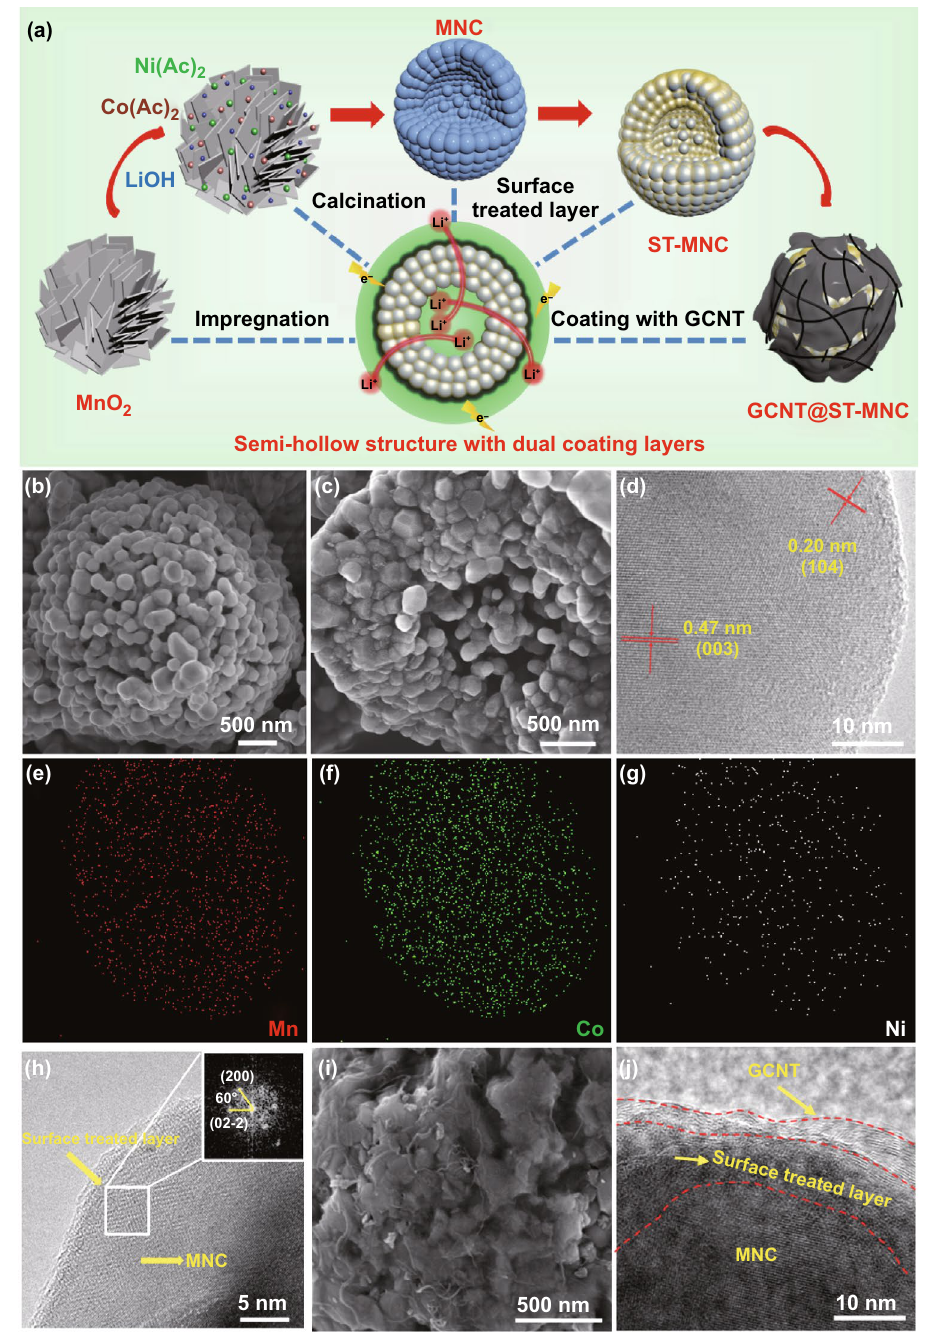
Fig. 2 a Schematic illustration of preparation process of GCNT@ST-MNC composites. b FE-SEM and c FE-SEM cross-sectional images of MNC. d High-resolution TEM (HR-TEM) image of MNC. e–g EDS mapping of ST-MNC. h HR-TEM image of ST-MNC. The inset is the fast Fourier transformed (FFT) pattern. i FE-SEM and j HR-TEM images of